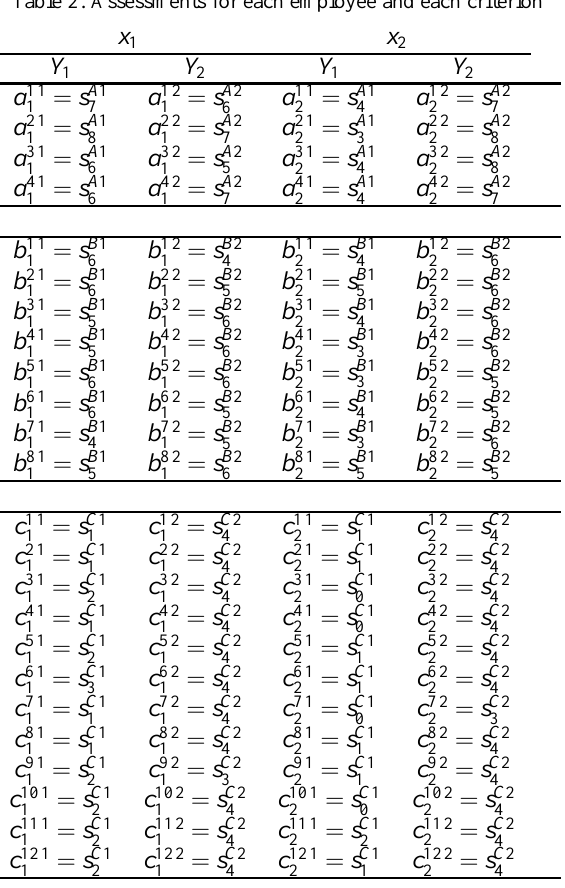
Table 2. Assessments for each employee and each